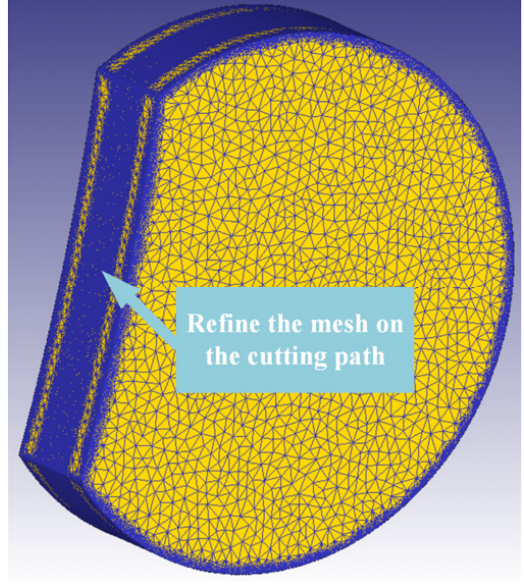
Figure 9. Re fi ned mesh on workpiece cu tt ing path. Figure 9. Refined mesh on workpiece cutting